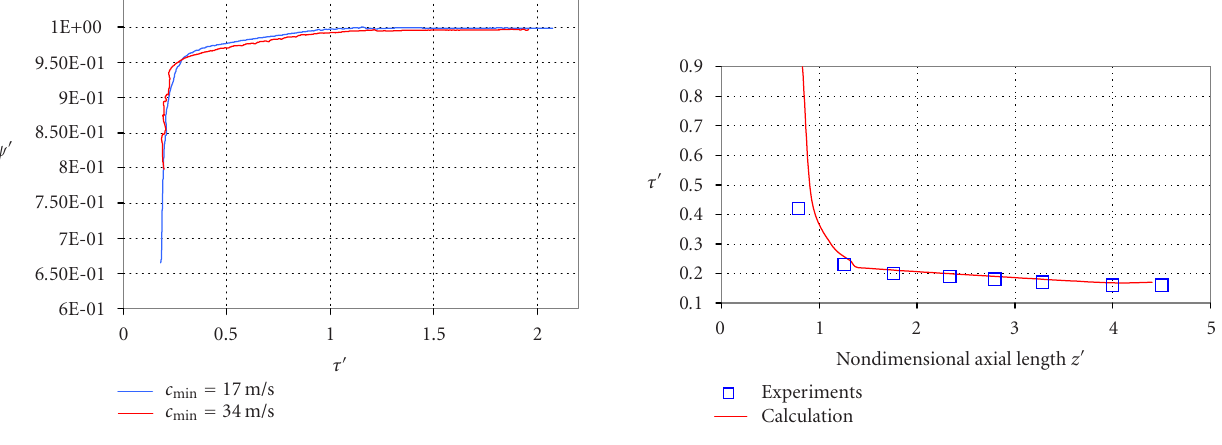
Figure 11: Evolution of the pressure measured by the taps located near the shroud.